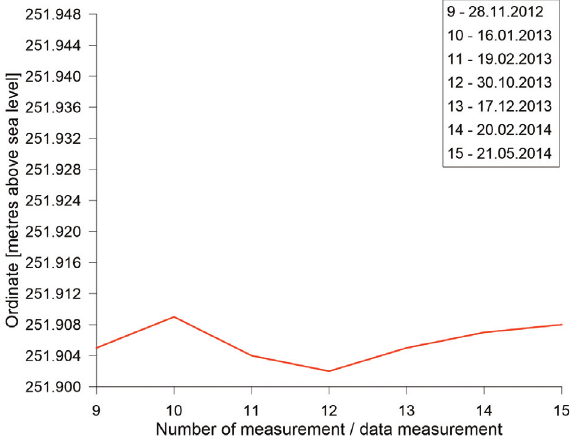
Fig. 5. Measurement point levels in the L-1 segment of the ventilation duct after the reinforcement of the foundation